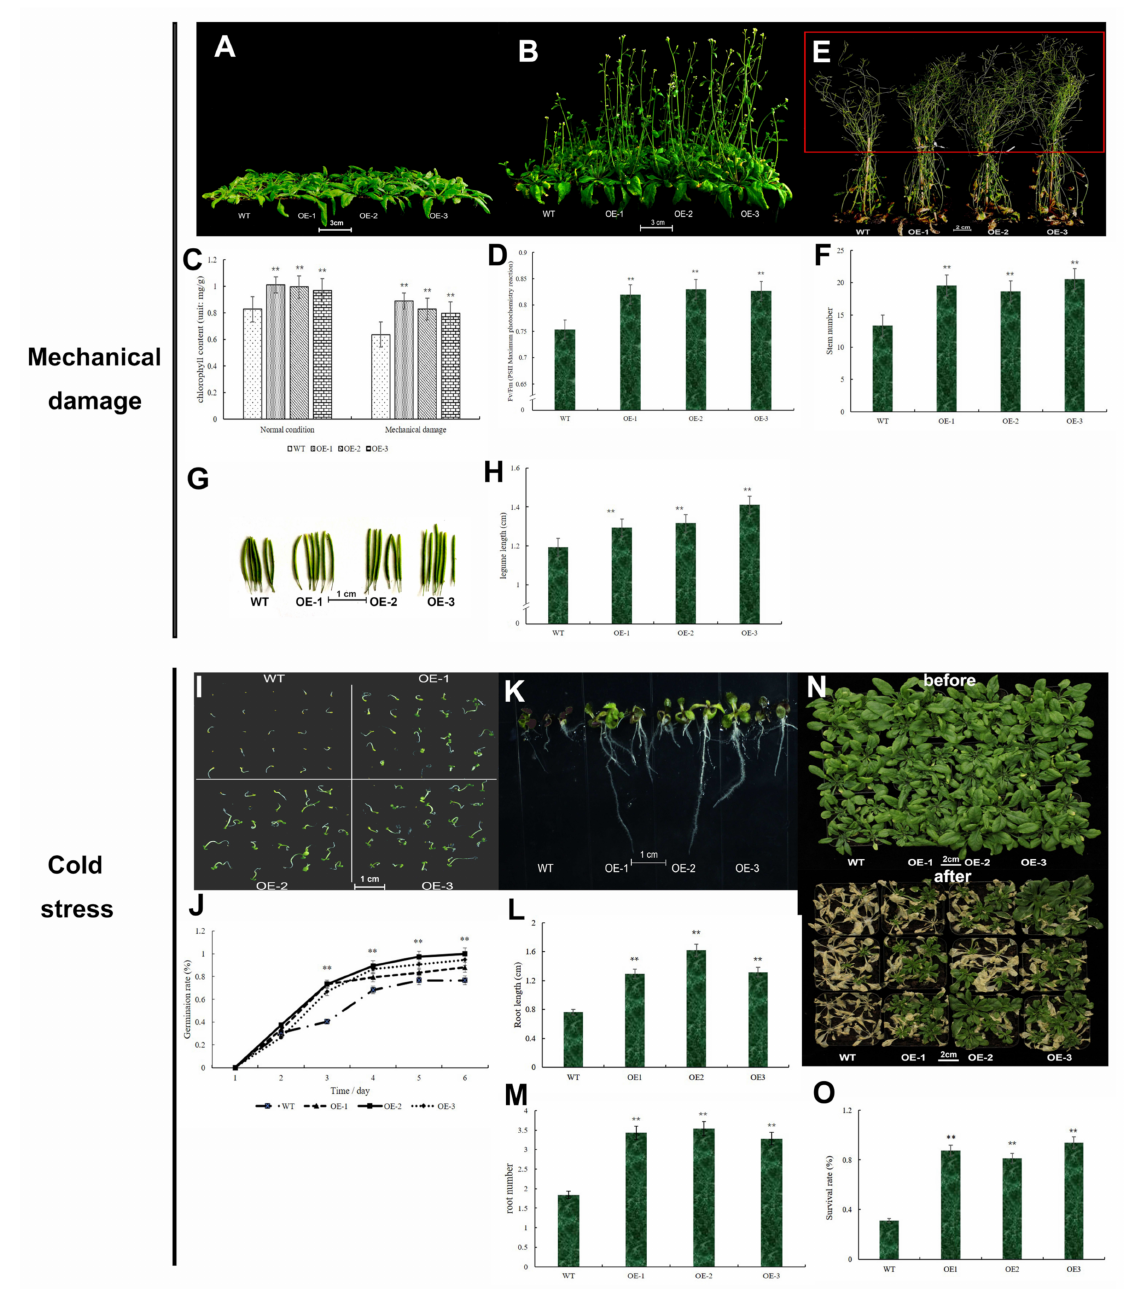
Figure 9. Phenotypes of WT and three transgenic lines after mechanical damage and under cold stresses. ( A , B ) Phenotypes of WT and three transgenic lines after mechanical damage. ( C ) Chlorophyll content in rosette leaves after mechanical damage. Six plants of each line were randomly selected, the rosette leaves of six plants were detected with spectrophotometer and repeated three times. ( D ) Fv/Fm after mechanical damage. Fv/Fm of twelve plants was detected in this study. ( E ) Four Arabidopsis at pod stage. ( F ) Stem number of four lines at pod period after mechanical damage. Six plant stems were counted. ( G , H ) Pod length, bar = 1 cm. Twenty pods located at the top of Arabidopsis plants were collected and measured. ( I , J ) The germination rate of four Arabidopsis lines after cold treatment. ( K – M ): Root length and number of four lines after cold treatment. The roots of twenty plants of each line were counted after cold treatment. ( N , O ) Phenotype of four lines after cold treatment and survival rate of four lines after cold treatment. Fifteen plants of each line were treated with cold for seven days, after treatment, the survival rate of each line was counted. **, p < 0.01 (Student’s t